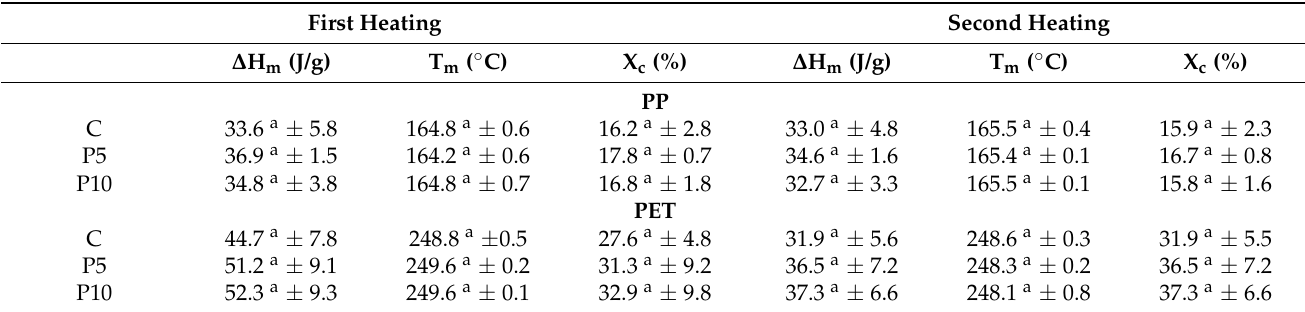
Table 4. Thermal properties of untreated (C) and cold plasma-treated PP and PET samples for 5 (P5) and 10 (P10) min. First Heating Second